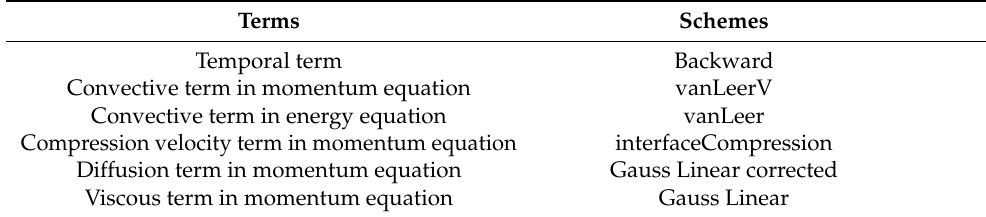
Table 2. The techniques for discretizing the solution algorithm for benchmark instances are listed in the following table. All of the schemes are standard second-order approaches that can be found in OpenFOAM solvers and are implemented as